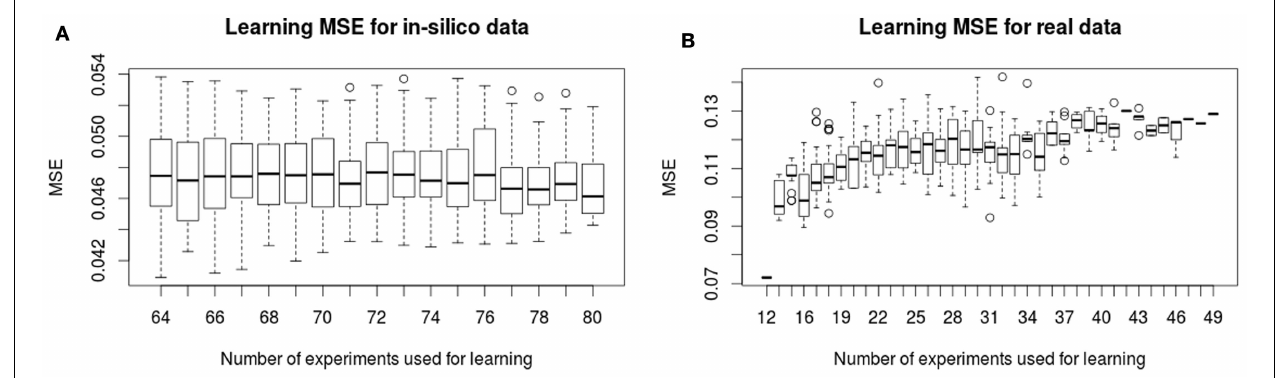
The Y -axis shows the learning MSE obtained at each iteration, it represents the quality of the learned models with respect to the experiments used in the learning step.